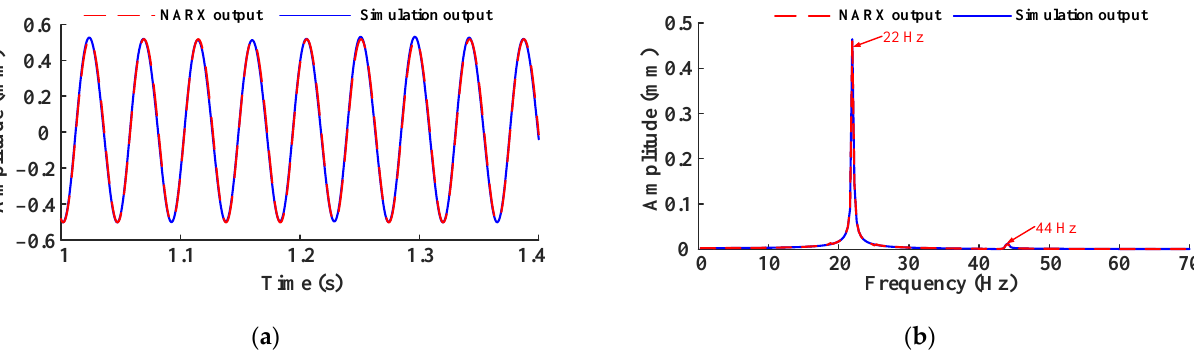
Figure 8. Response of the disk in x -direction ( ω = 100.5 rad/s): ( a ) time domain; ( b ) frequency domain.